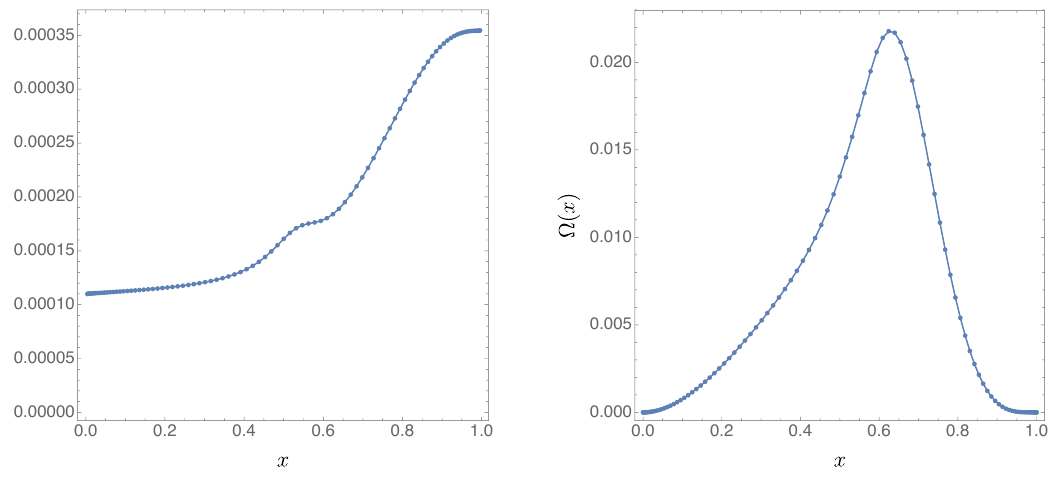
Figure 5 . Left: The determinant h as a function of x on H + plotted for (cid:12)xed T 1 =T BH (cid:25) 0 : 557103. Right: The coordinate velocity (cid:10)( x ) on H + plotted as a function of x for (cid:12)xed T 1 =T BH (cid:25) 0 : 557103.